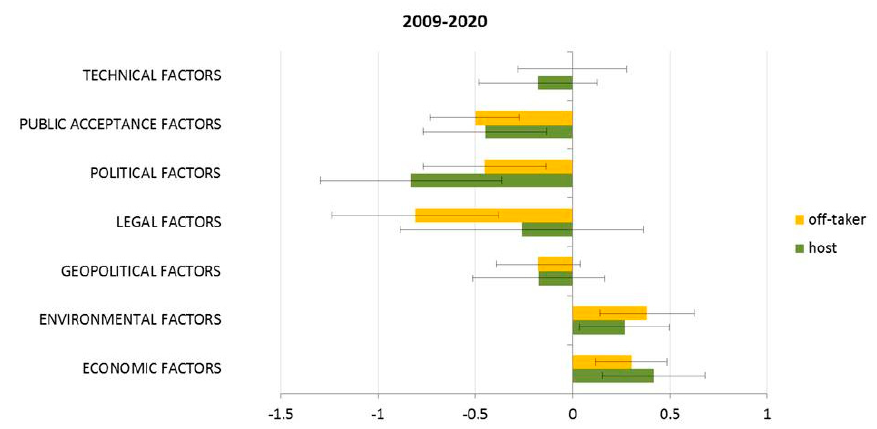
Figure 2. Factor relevance per category for off-taker and host countries (past). Source: Own elaboration. The end of the bars indicate observed means and the horizontal line segments ("error bars") represent the confidence intervals around them. No significant differences have been found.